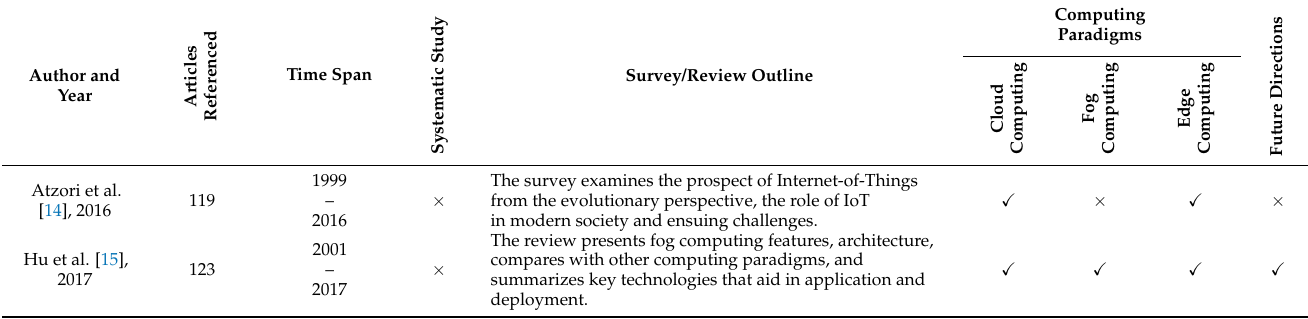
Figure 3. Number and year of publications studied in this review. The review/survey papers analyzed in this study is elucidated in Table 2. Table 2. Review/survey papers and their contributions.